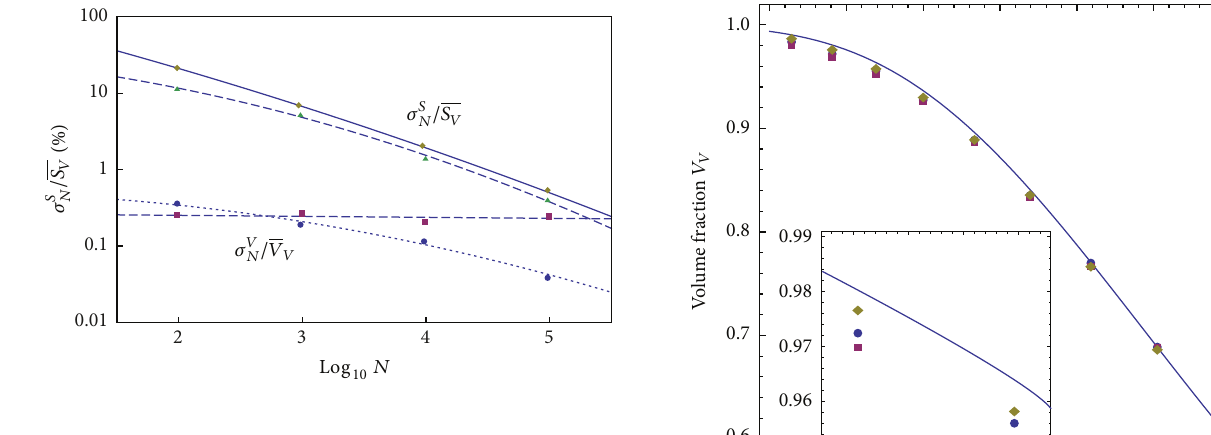
Figure 5: Normalized standard deviation 𝜎 𝑉 𝑁 /𝑉 𝑉 and 𝜎 𝑆 𝑁 /𝑆 𝑉 of respectively volume fraction, 𝑉 𝑉 , and specific surface area, 𝑆 𝑉 , of cherry-pit models with Gamma distributed radii and 𝜎/𝑟 = 0.707 versus number 𝑁 of spheres used for the construction of a model. The standard deviation is calculated from 10 samples for each model. 𝜆 = 0.75 , triangles and dashed line: 𝑆 Figure 6: Volume fraction of cherry-pit models for Gamma dis- 𝑉 : rhombuses and solid line: 𝜆 = 0.75 , squares and dashed 𝜆 = 0.95 ; 𝑉 tributed pore size with 𝜎/𝑟 = 0.25 (rhombs), 0.71 (squares), and 1.00 𝑉 : circles and dotted line: (circles). line: 𝜆 = 0.95 .